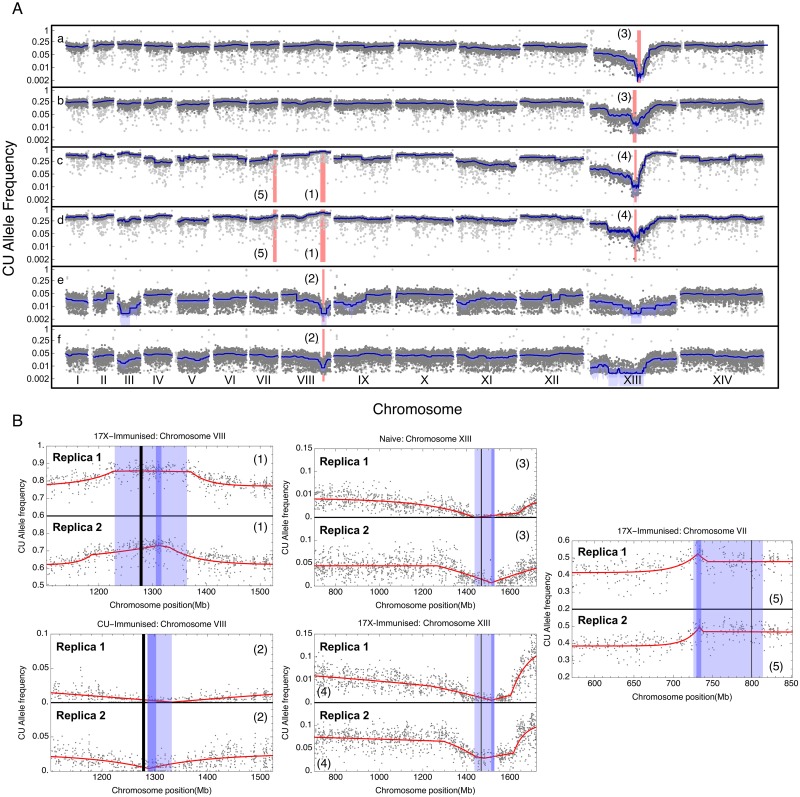
Genome-wide sequencing data.(A) Genome-wide Plasmodium yoelii CU allele frequency of two independent genetic crosses grown in (a,b) naïve mice, (c,d) 17X1.1pp immunized mice and (e,f) CU-immunized mice. Light gray dots represent observed allele frequencies. Dark gray dots represent allele frequencies retained after filtering. Dark blue lines represent a smoothed approximation of the underlying allele frequency; a region of uncertainty in this frequency, of size three standard deviations, is shown in light blue. A conservative confidence interval describing the position of an allele evolving under selection is shown via a red bar. Allele frequencies are shown in log scale. (B) Evolutionary models fitted to allele frequency data. Filtered allele frequencies are shown as gray dots, while the model fit is shown as a red line. Dark blue and light blue vertical bars show combined and conservative confidence intervals for the location of the selected allele as reported in Table 3. Numbers in parentheses equate figures with locations in (A). A black vertical line shows the position of a gene of interest.